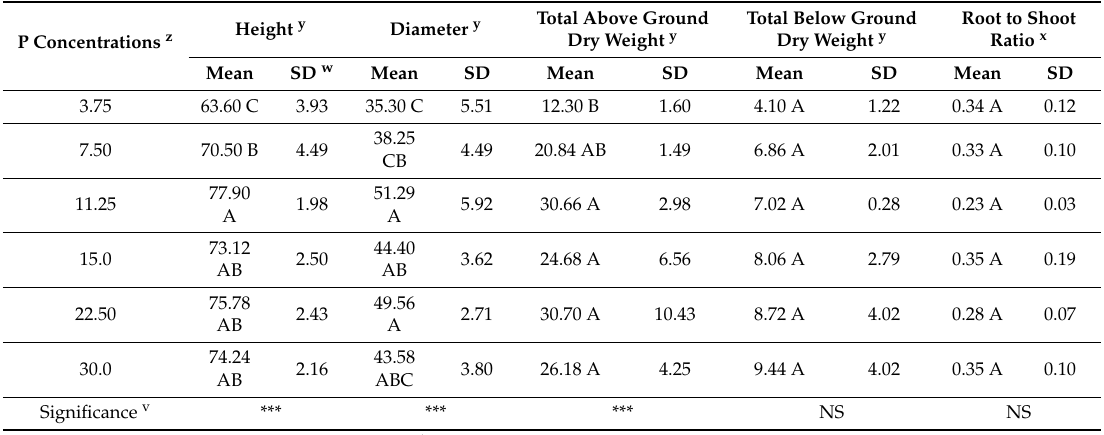
Table 2. The impacts of phosphorus (P) fertility on plant growth metrics of C. sativa “BaOx” after eight weeks of vegetative growth.